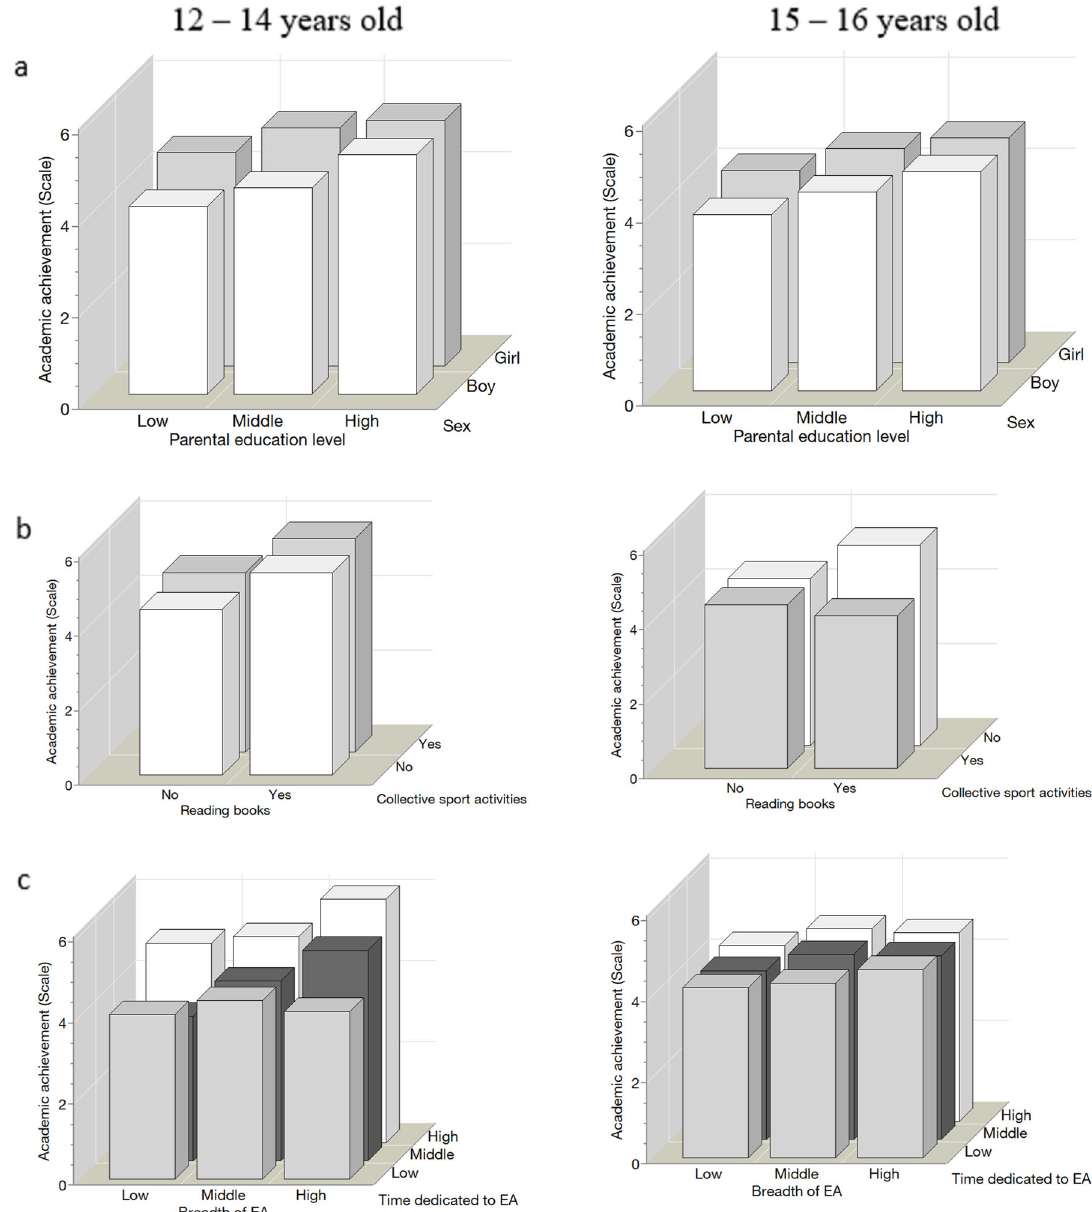
Fig. 1 Means of academic achievement grouped by age sets, predictors, and confusing factors. a Sex and parental education level; b breadth and duration of EA; and c collective sports activity and reading of